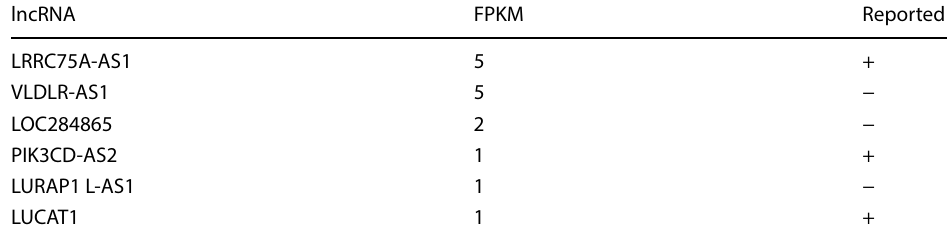
Table 12 Top six treatment- specific lncRNA transcripts in OS-R compared to OS cells